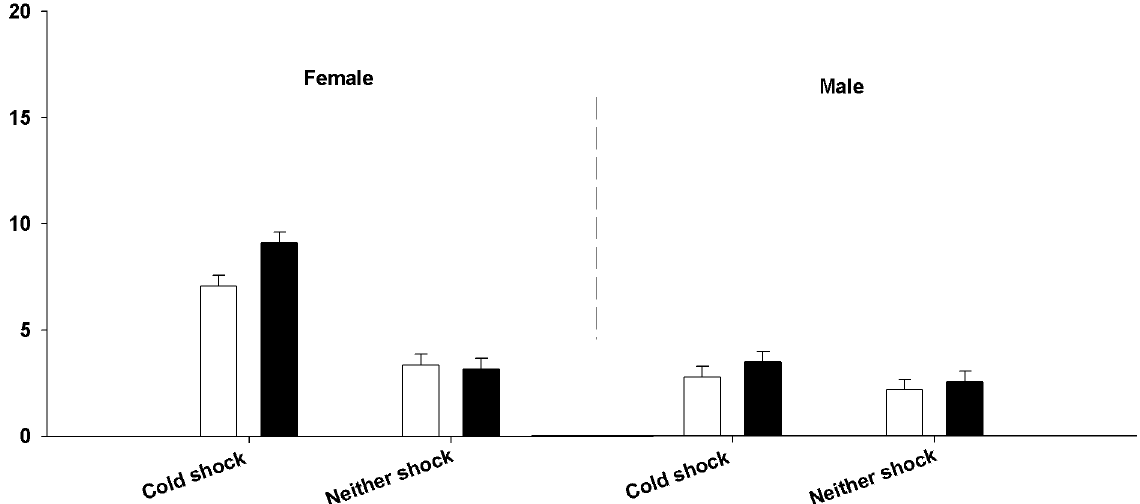
Experiment 4: Post cold shock, selected males are better at mating non- virgin females and siring progeny The non-virgin females in this experiment came from a base population with a recessive eye color marker (scarlet). The females were previously mated to males from their own population. Thus any female that produced progeny with dominant eye color marker (red) would have mated with FCB or FSB males at least once. We found that the proportion of females that pro- duced red eyed progeny was significantly more when the females were held with FSB males